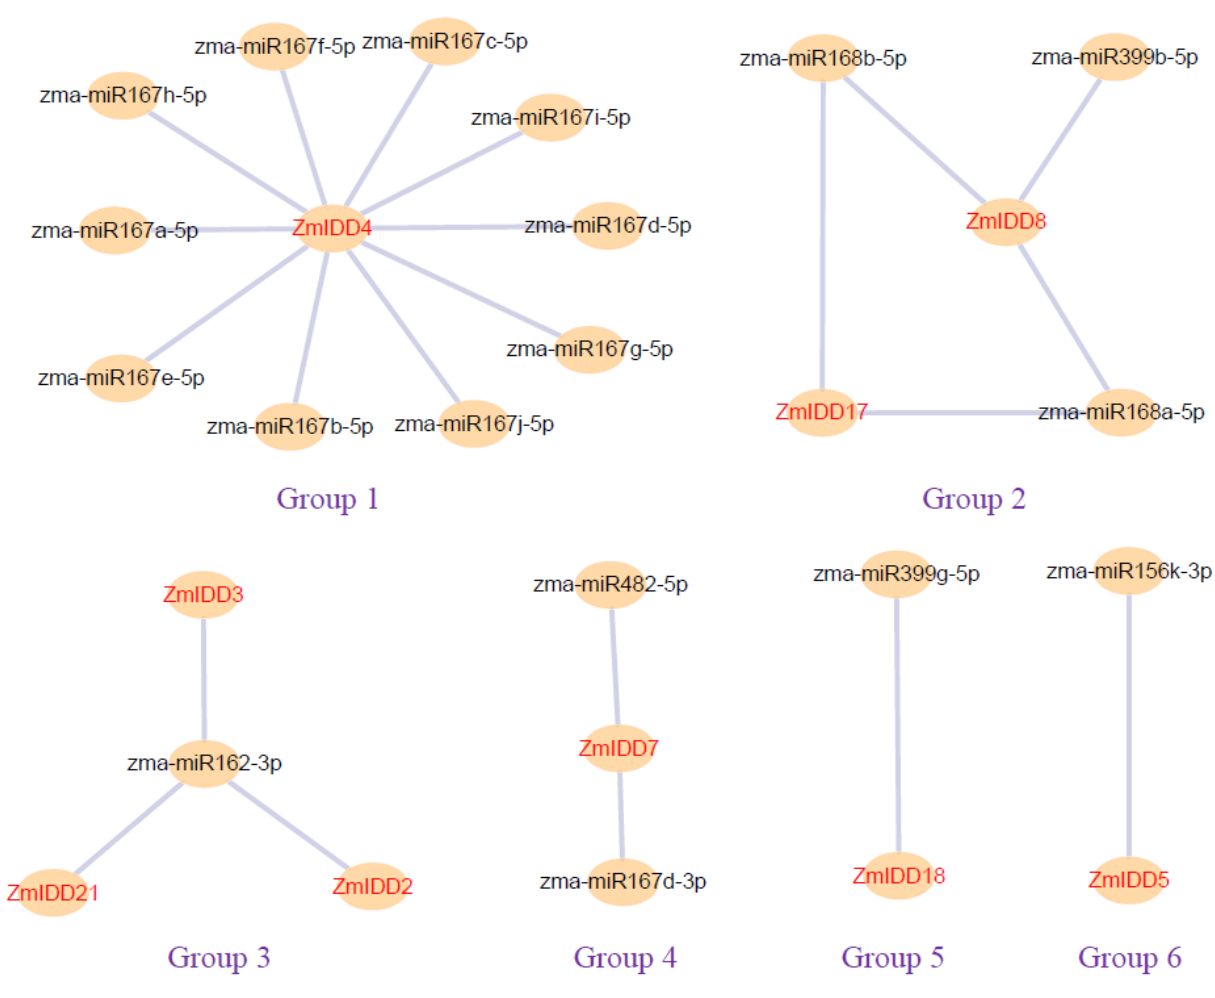
Figure 10. Interaction networks between miRNAs and miRNA-acted ZmIDDs . Information on miRNAs and miRNAs-acted ZmIDDs is shown in Table S13.